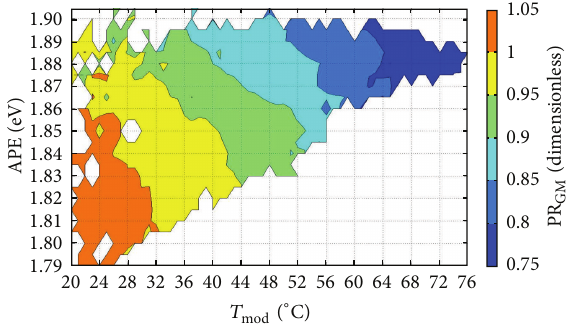
Figure 4: Contour graph of PR GM of the tested CIGS PV module as a function of 𝑇 mod and APE. Blank areas indicate no data points.